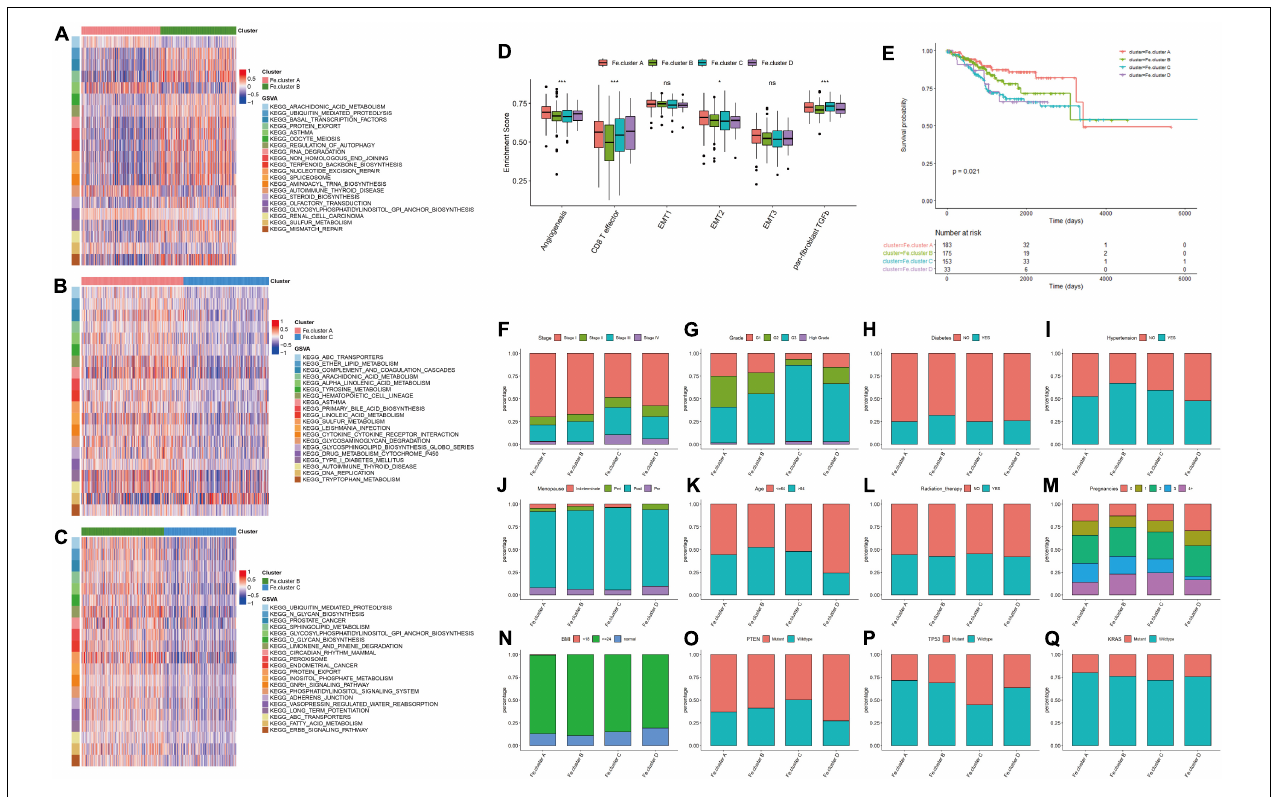
FIGURE 3 | Molecular and clinical characteristics of clusters. (A) The top 20 differential enrichment pathways of Fe.cluster A and Fe.cluster B. (B) The top 20 differential enrichment pathways of Fe.cluster A and Fe.cluster C. (C) The top 20 differential enrichment pathways of Fe.cluster B and Fe.cluster C. (D) The differences in the enrichment scores of the main tumor-related biological processes in different Fe.clusters. (E) Kaplan–Meier survival curve of Fe.clusters. (F–Q) The distribution of stage, grade, diabetes, hypertension, menopausal status, age, radiotherapy status, fertility status, BMI, PTEN, P53, and KRAS mutation status between the Fe.cluster groups. * p < 0.05 and *** p < 0.001.